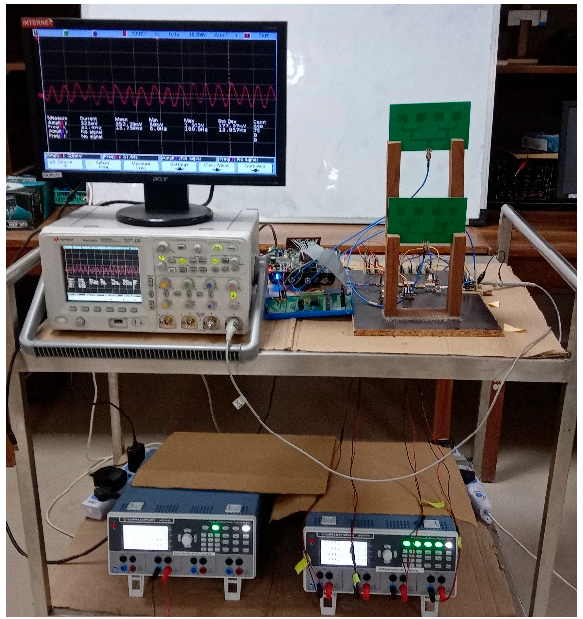
Figure 2. Photograph of the developed radio-frequency (RF) sensor’s experimental setup.